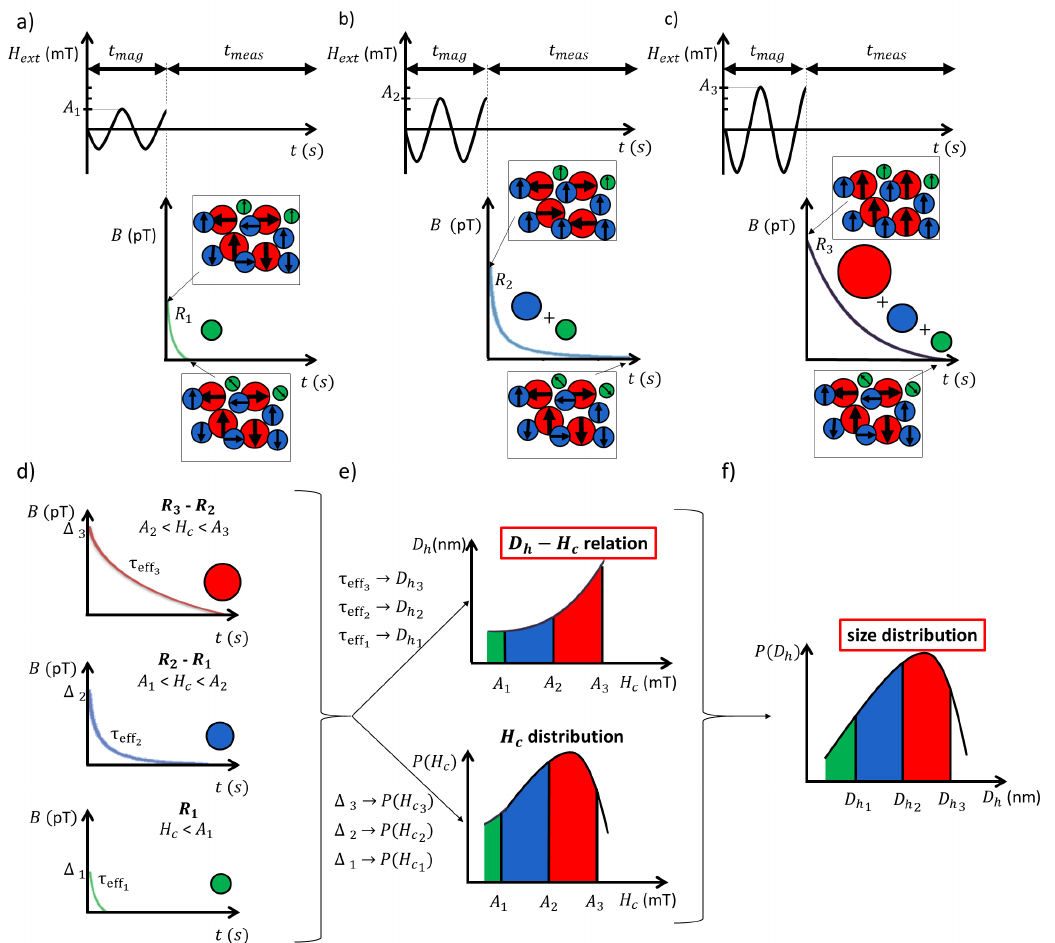
Figure 1. Overview of the different steps of the presented characterization technique for the case of a magnetic nanoparticle (MNP) system consisting of three particle types. In panels ( a – c ), the MNP sample is exposed to an AC magnetic field pulse with amplitude A 1 , A 2 , and A 3 , respectively, which is applied for the duration of t mag . Only particles with coercivity lower than the pulse amplitude will align themselves to the pulse direction (inset at beginning of the recording). After the pulse is switched off, this gives rise to a decaying magnetic moment which is recorded for a duration of t mag seconds. At the end of their relaxation, the particles’ magnetic moments are randomly oriented (inset at the end of the decaying signal). By exposing the sample to pulses of different amplitudes, the associated measurements will contain the response of different sets of particles. In this example, the amplitudes are chosen such that the first pulse ( a ) excites only the first particle type, the second pulse ( b ) the first and second particle type, and the third pulse ( c ) all the particle types. ( d ) Subtracting subsequent measurements allows to retrieve the hydrodynamic diameter ( D h ) and the amount of particles with a specific coercivity ( P ( H c ) ) from the relaxation time and amplitude of the difference signals. ( e ) The information from the difference curves unveils the D h − H c relation and H c distribution for the MNP sample. ( f ) This information can then be combined to retrieve the particle size